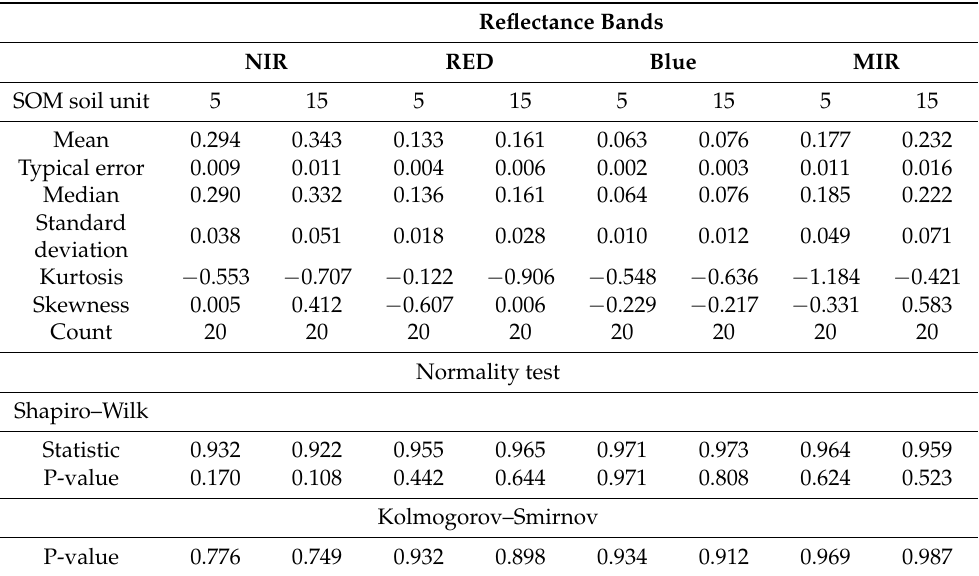
Table 3. Statistics of MOD13Q spectral bands series for SOM5 and SOM15 for DOY 49 associated to bare soil as predominant condition for the period 2000 to